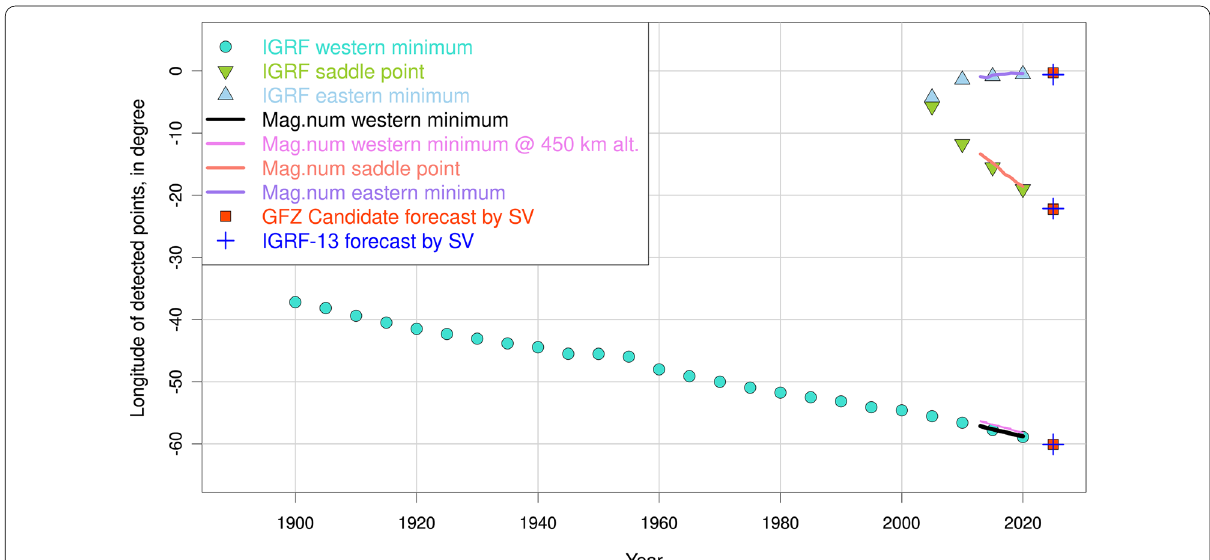
Fig. 9 Longitudinal drifts (see legend) of the two minima and the saddle-point between them from the full period IGRF (symbols) and of the more recent epochs from Mag.num